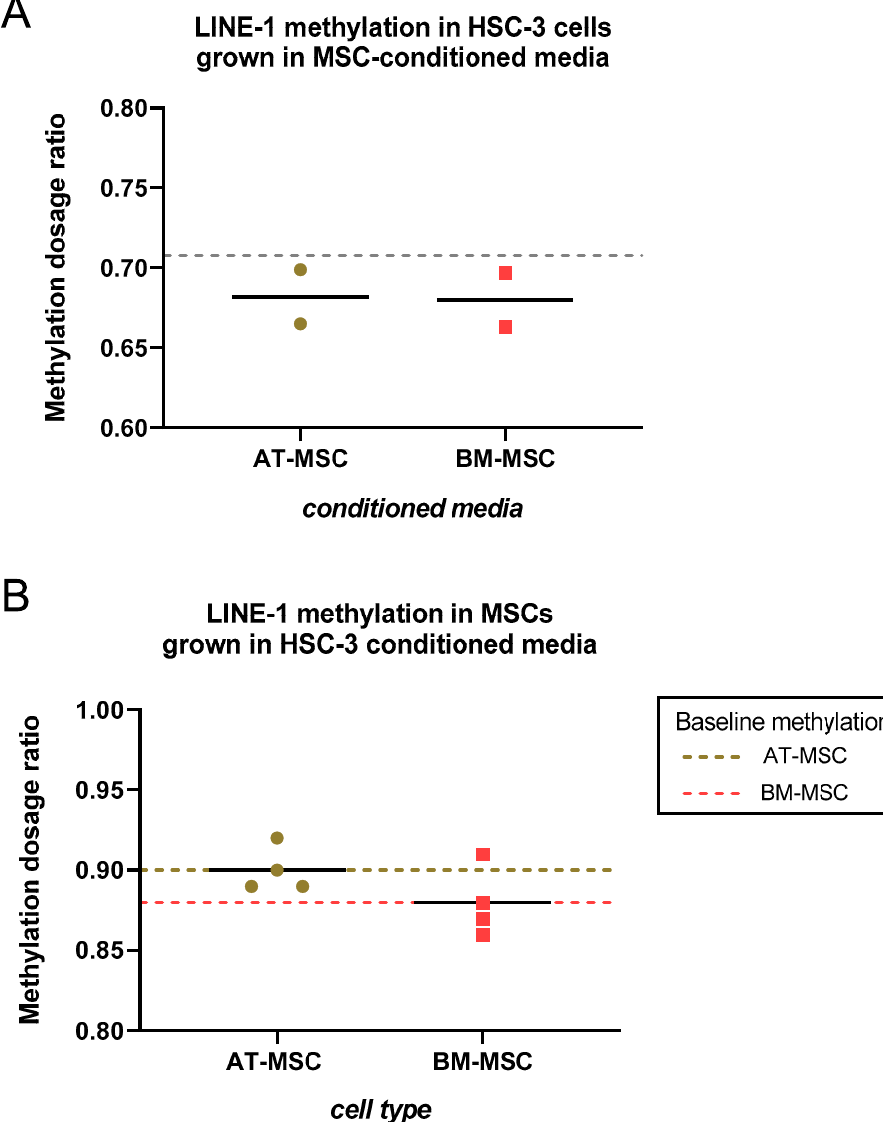
Figure 2. E ff ect of HSC-3- and mesenchymal stem cells (MSCs)-conditioned media on LINE-1 methylation in target cells. ( A ) HSC-3 cells were grown in (AT- and BM-) MSCs-derived conditioned media. DNA was isolated from cells and LINE-1 methylation was analyzed by methylation-specific multiplex ligation-dependent probe amplification (MS-MLPA). The dashed line, baseline methylation, is based on HSC-3 cells grown in serum-free media. ( B ) AT-MSCs (olive green) and BM-MSCs (red) were grown in HSC-3-derived conditioned media. DNA was isolated from cells and LINE-1 methylation was analyzed by MS-MLPA. Dashed lines represent baseline methylation for each cell type, based on MSCs growing in serum-free media.